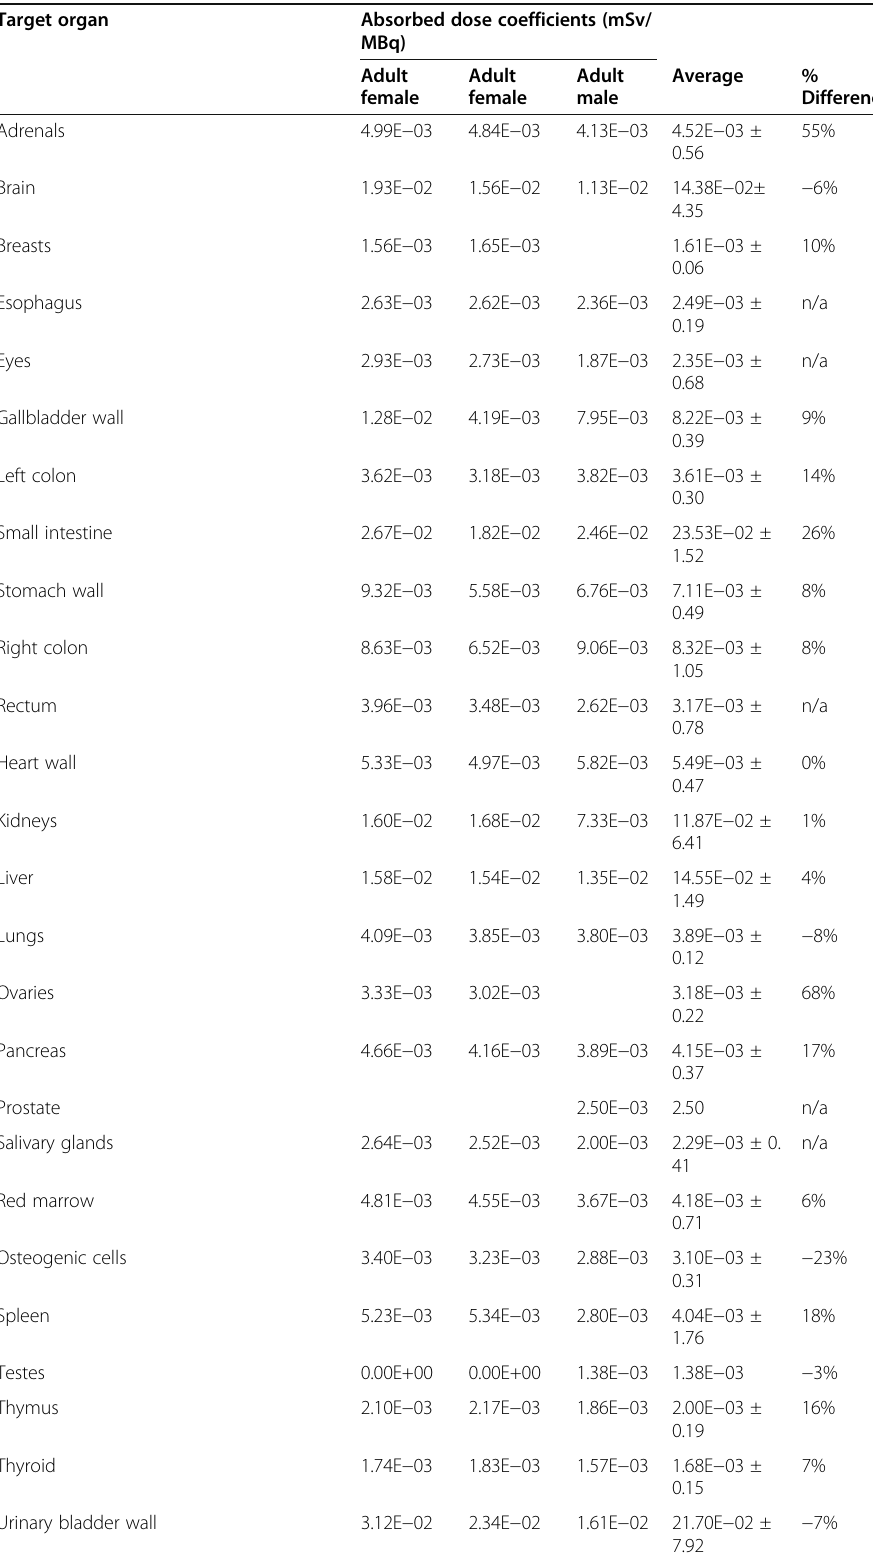
Table 4 Absorbed dose coefficients for [ 11 C]-UCB-J determined from three healthy subjects using OLINDA/EXM 2.1, compared to OLINDA/EXM